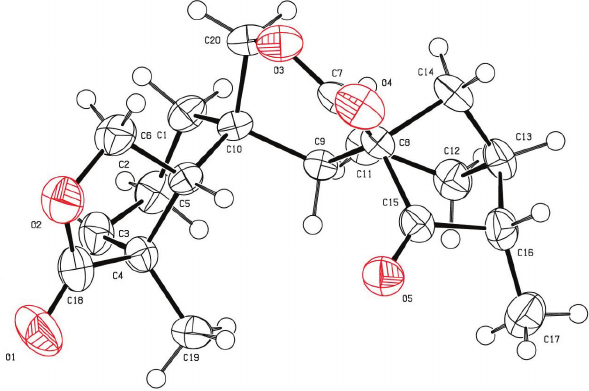
Table 2: Fractional atomic coordinates and isotropic or equivalent isotropic displacement parameters (Å 2